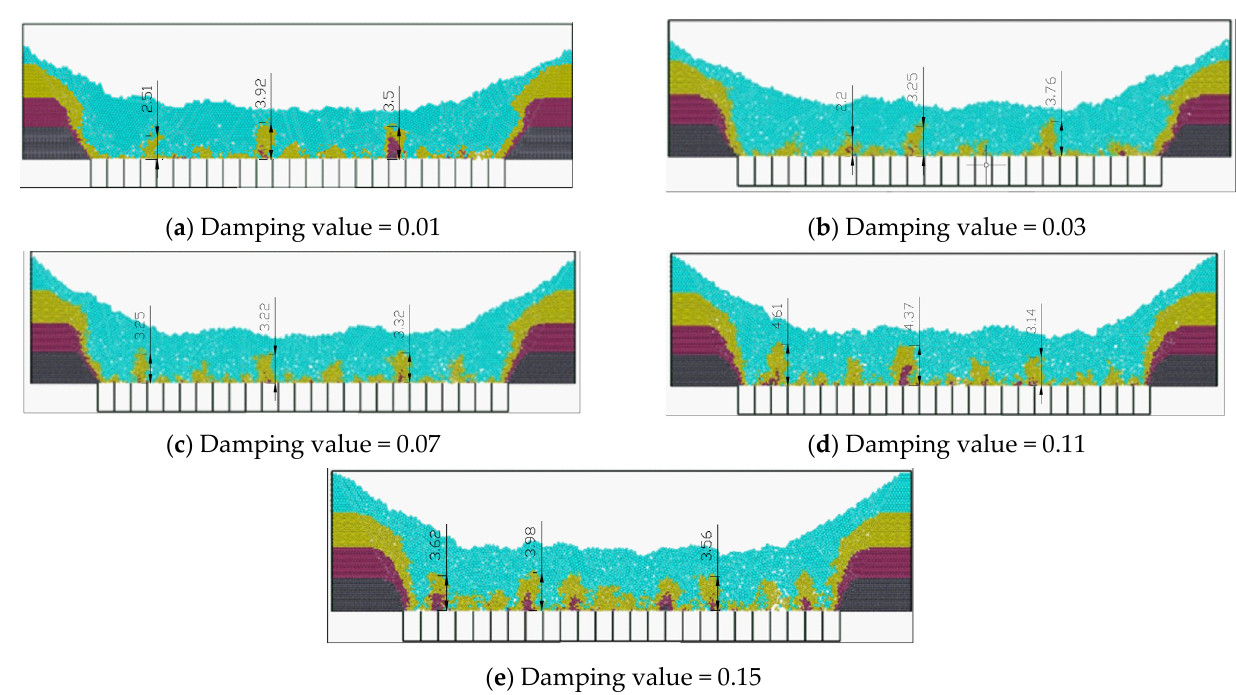
Figure 8. Results of coal-rock interface of Level 4 under different damping values (The unit in the picture is